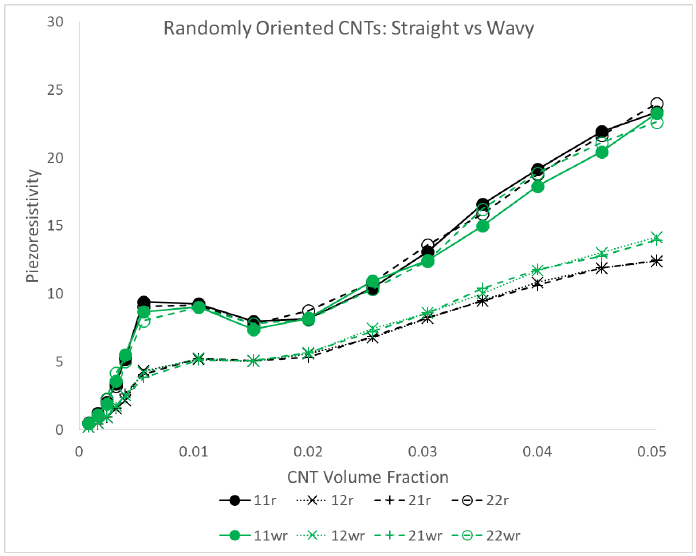
Figure 29. Mean of all non-zero piezoresistivity terms for the randomly oriented straight and randomly oriented wavy